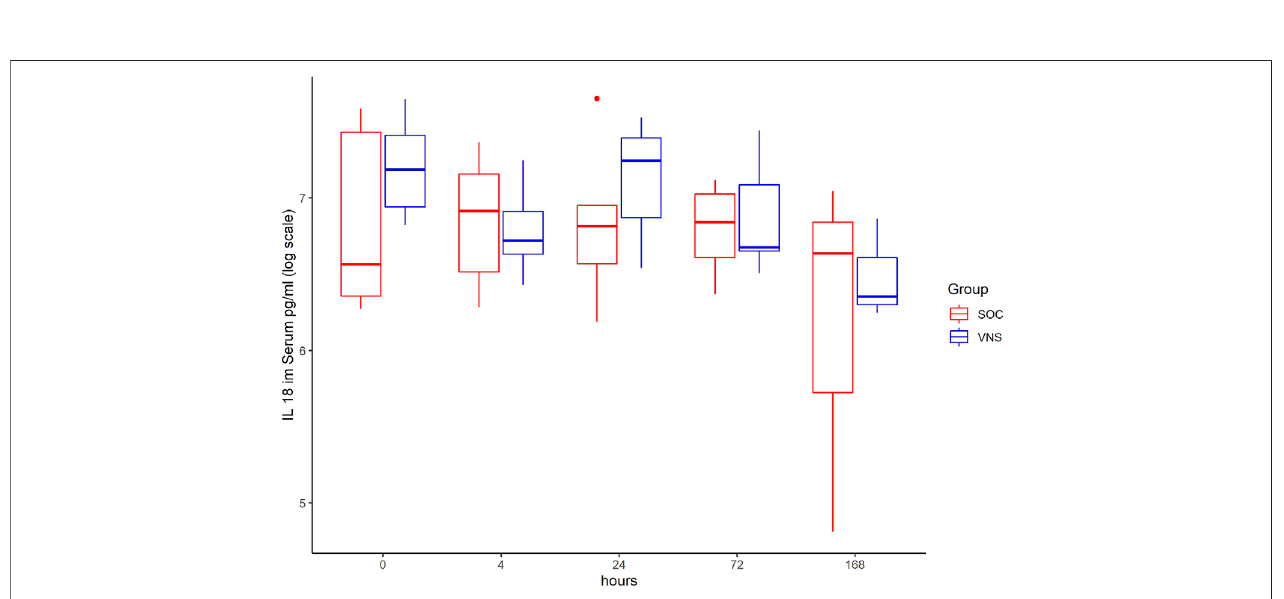
FIGURE 4 | Median IL-18 level with Interquartile Range of patients receiving auricular Vagus Stimulation (VNS = blue) and patients only receiving Standard of Care (SOC = red) after 0, 4, 24, 72, and 168 h of study inclusion.